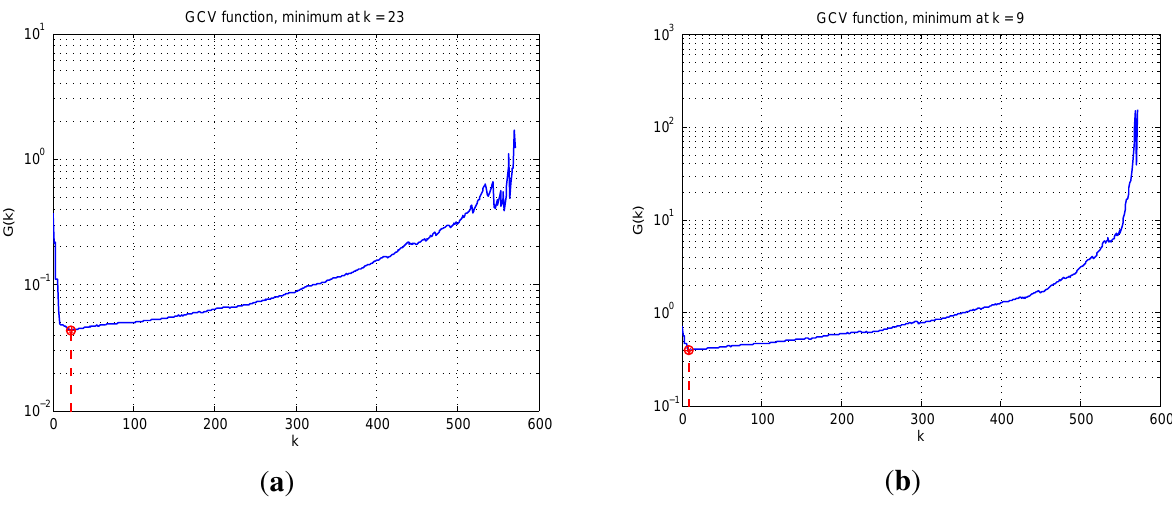
Figure 7. The valuation of generalized cross-validation (GCV) function versus truncation parameters with different noise levels. ( a ) SNR = 10 dB; ( b ) SNR = 0